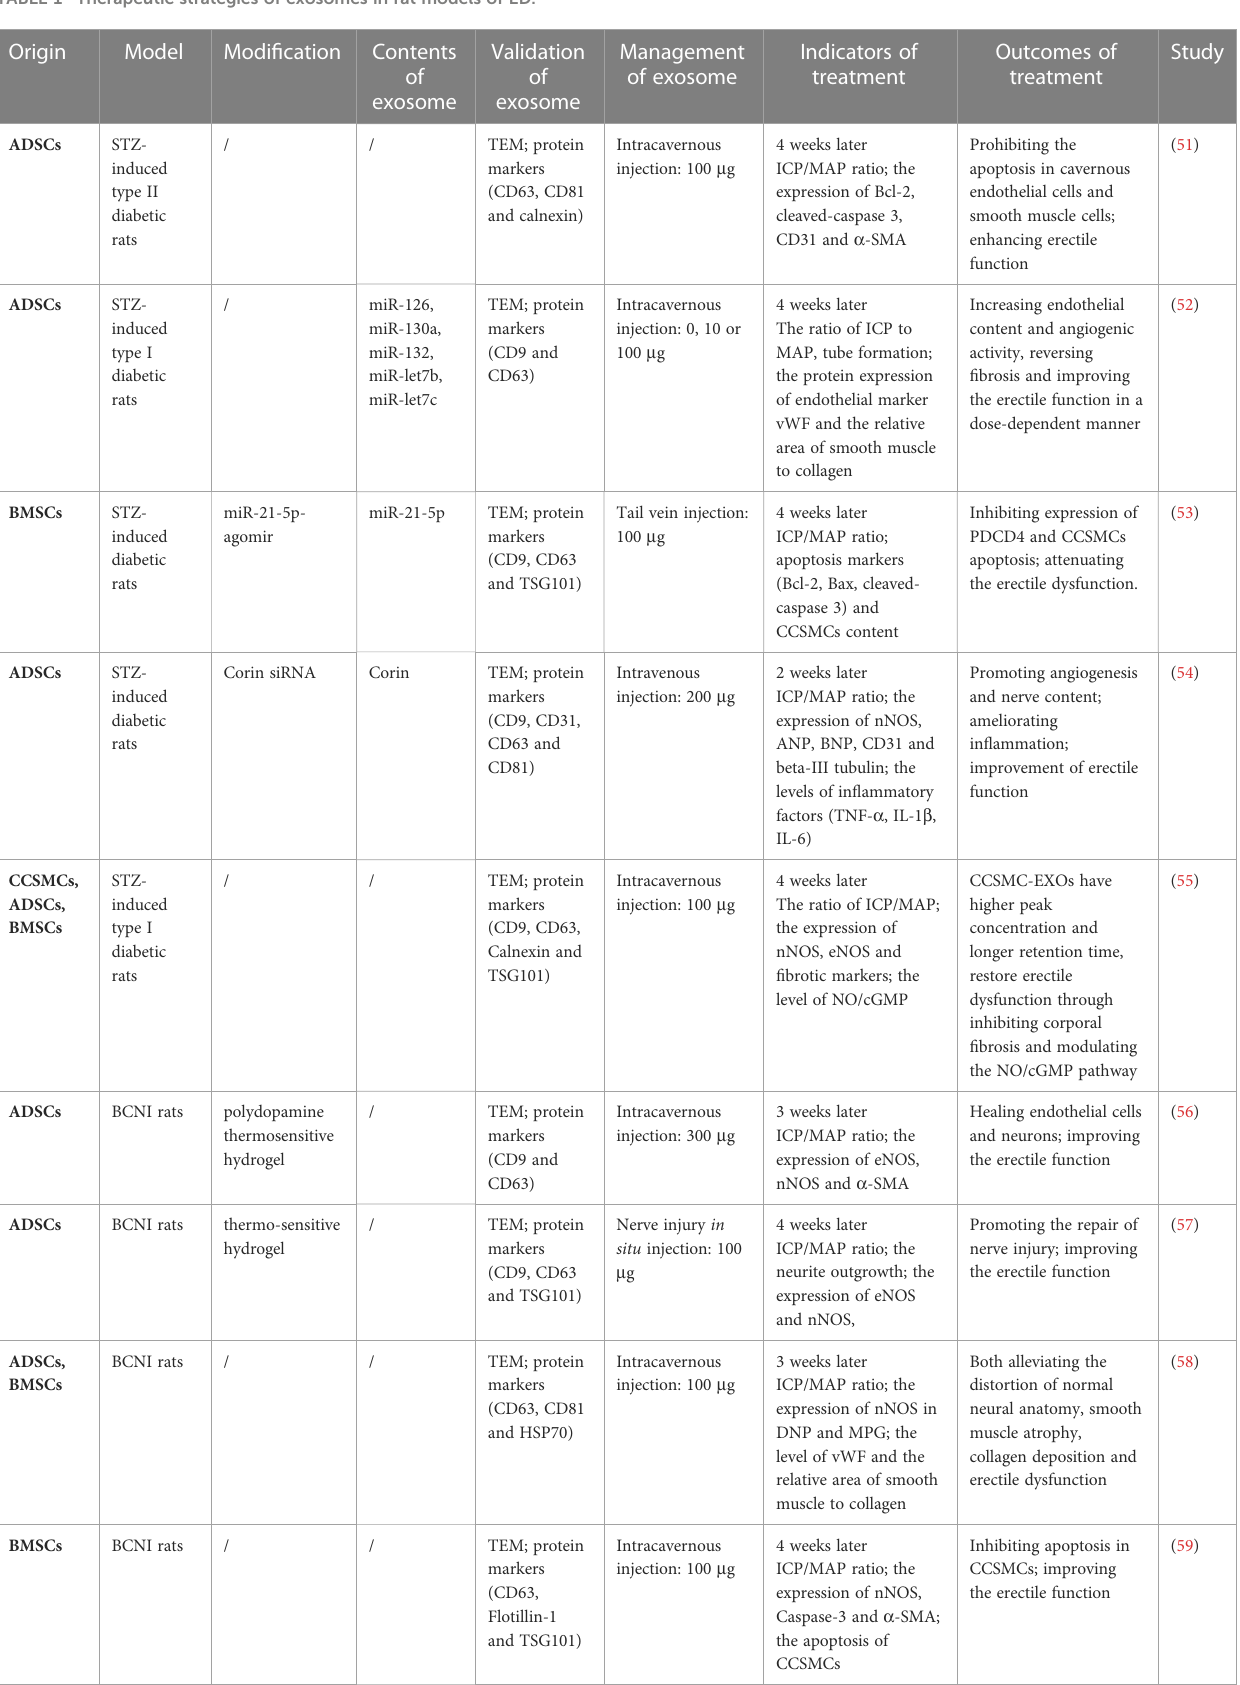
TABLE 1 Therapeutic strategies of exosomes in rat models of